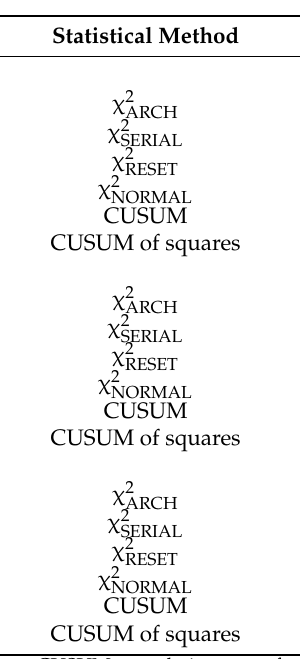
Table 6. Results of diagnostic